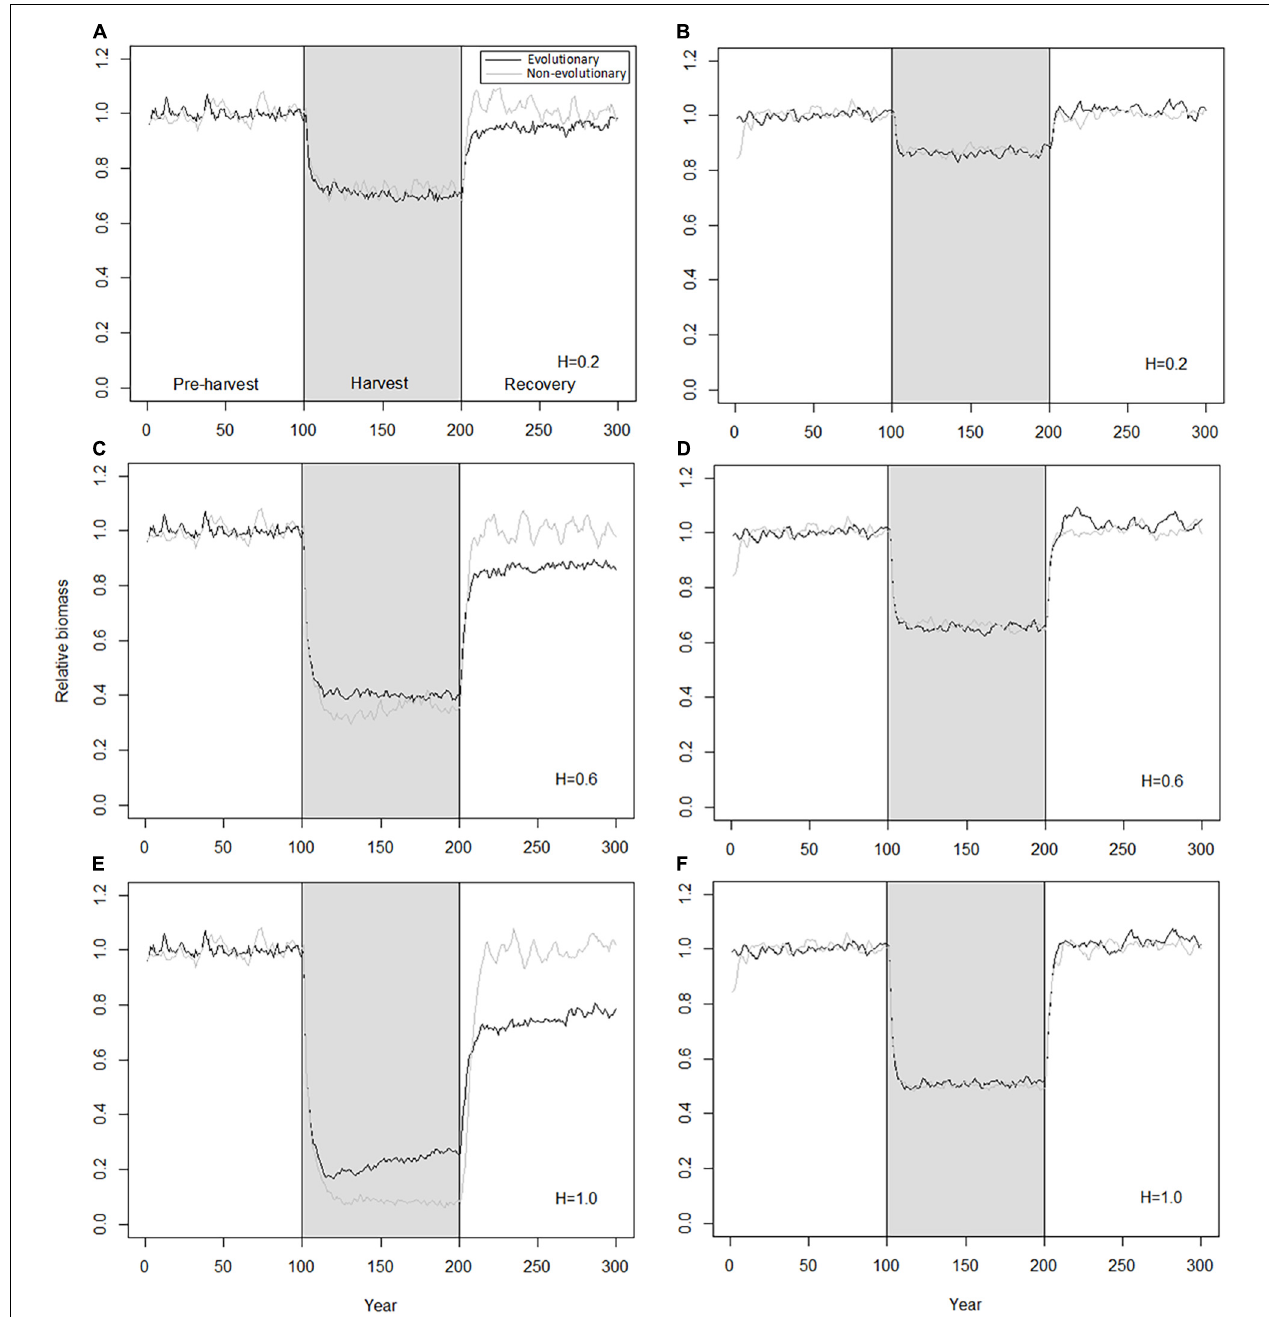
FIGURE 2 | Decrease and subsequent recovery of population biomass (of individuals aged 1 year and older) in dependence on instantaneous harvest rate (increasing from top to bottom). Black curves, evolutionary model; gray curves, non-evolutionary model; gray shading, harvest period. (A,C,E) Panels with sigmoid size-selectivity curves as is typical for trawl, and (B,D,F) panels with bell-shaped size-selectivity curves for examples with gillnet.